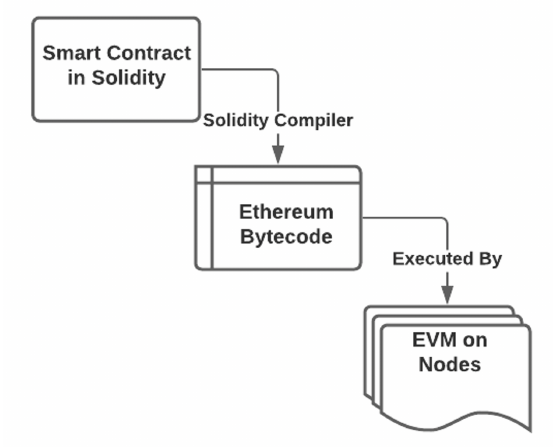
Figure 5. The workflow of Ethereum smart contract